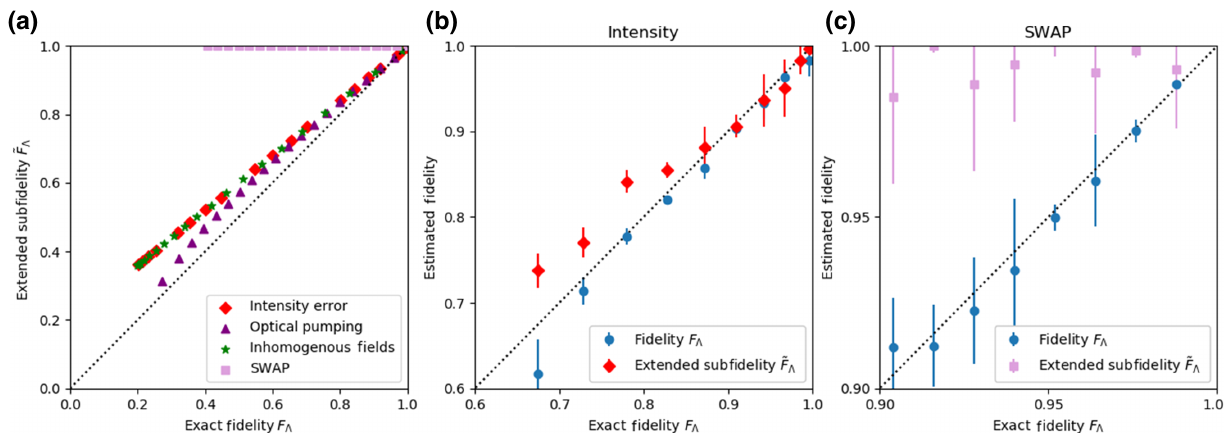
FIG. 4. (a) The extended subfidelity ˜ F (cid:4) of Ref. [23] versus the exact fidelity F (cid:4) that we can estimate in our paper, for a selection of error channels of varying strengths: intensity errors, which correspond to an overrotation e − i (cid:15) ZZ ; optical pumping errors, which cause amplitude damping on each qubit; inhomogeneous fields, which cause phase damping on each qubit; and SWAP errors, which interchange the qubits. This plot corresponds to the exact value of both F (cid:4) and ˜ F (cid:4) that one estimates in an experiment. Note that while the ˜ F (cid:4) agrees with F (cid:4) in the limit F (cid:4) → 1, in general the two do not agree, and there exists worst-case errors such as SWAP that ˜ F ˜ F (cid:4) cannot detect. (b),(c) Simulation of an experiment that estimates F (cid:4) versus (cid:4) for a total of 300 000 unitaries, in the case of (b) intensity and (c) SWAP errors of varying strengths. These plots correspond to experiments that estimate the exact values shown in (a). We see that the difference between F (cid:4) and ˜ F (cid:4) can be discerned in a realistic